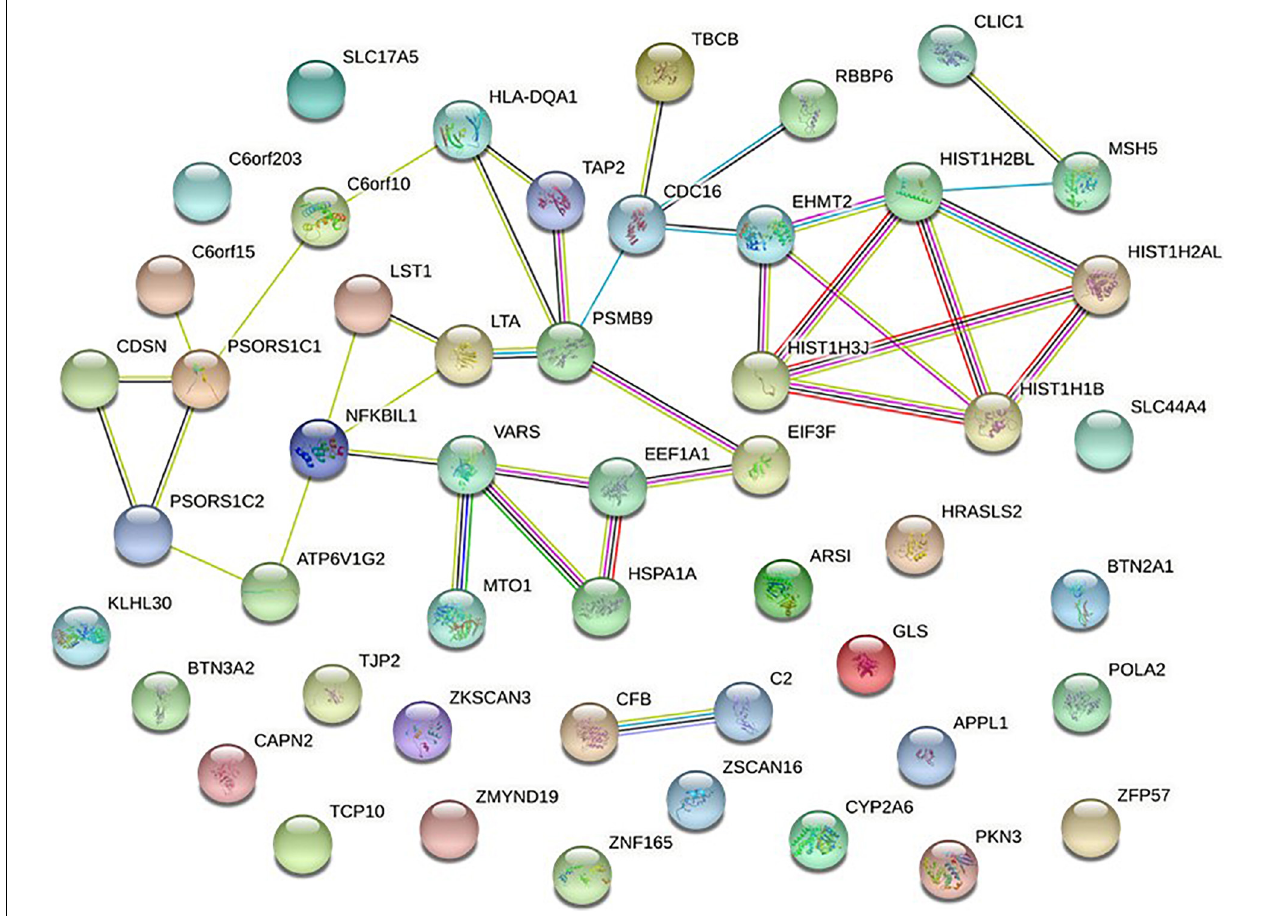
FIGURE 2 | Network of known and predicted interactions between proteins encoded by NMOSD potential susceptibility genes were identified by GWAS of AQP4-positive NMOSD. Network nodes represent the proteins produced by a single, protein-coding gene locus. Edges represent protein-protein associations meant to be specific and meaningful. In STRING, blue edge represents protein-protein associations with known interactions from curated databases, purple edge represents protein-protein associations with known interactions experimentally determined, green edge represents protein-protein associations with predicted interactions with gene neighborhood, red edge represents protein-protein associations with predicted interactions with gene fusions, Navy blue edge represents protein-protein associations with predicted interactions with gene co-occurrence, and other associations with text mining (yellow edge), co-expression (black edge), and protein homology (lavender